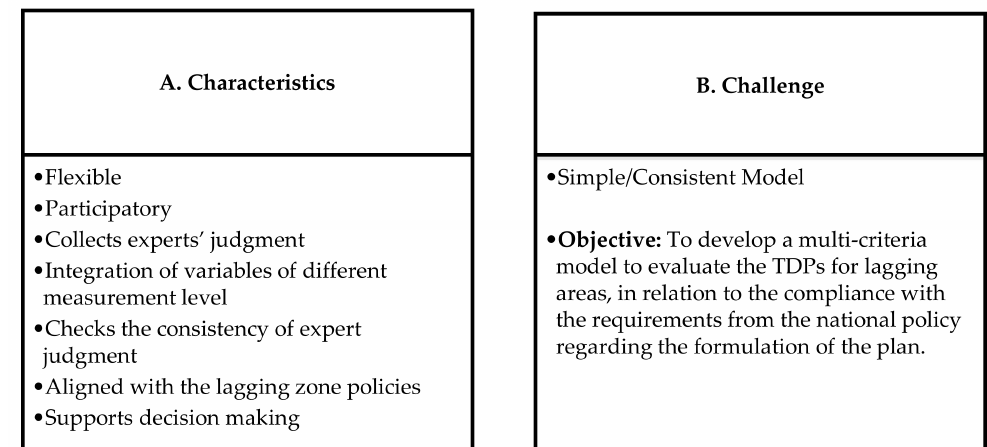
Figure 1. ( A ) Characteristics of the multi-criteria model to be developed for assessing TDPs for lagging areas; ( B ) challenge and objective of the multi-criteria model to be developed for the assessment of TDPs for lagging areas. TDP—Territorial Development